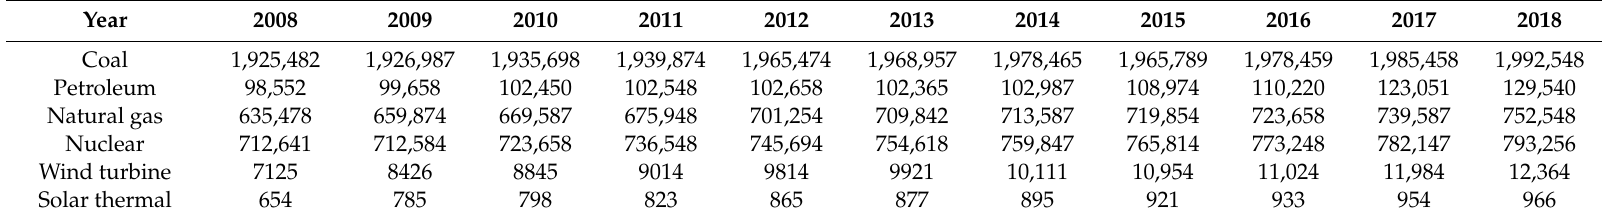
Table 4. Energy generation (in megawatts) of the area using di ff erent technologies.